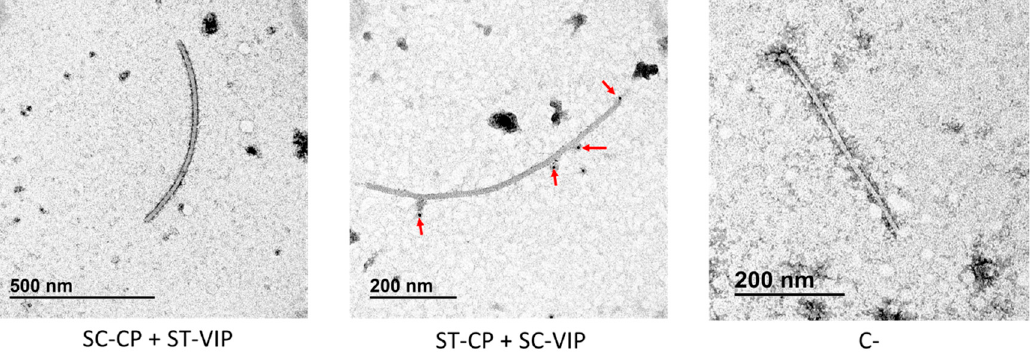
Figure 7. Representative immunogold electron microscopy micrographs of the two co-agroinfiltrated constructs of TuMV VLPs-VIP using SpyTag/SpyCatcher technology. Both constructs were decorated with anti-VIP as a primary antibody and gold-labelled anti-rabbit for decoration. The red arrows highlight the gold nanoparticles attached to the VLPs. Interaction between eVLPs with anti-VIP antibody could only be demonstrated in the ST-CP + SC-VIP construct (central panel). ST: SpyTag; SC: SpyCatcher; CP: TuMV capsid protein; VIP: vasoactive intestinal peptide; C-: negative control of an eVLP without immunogold decoration.